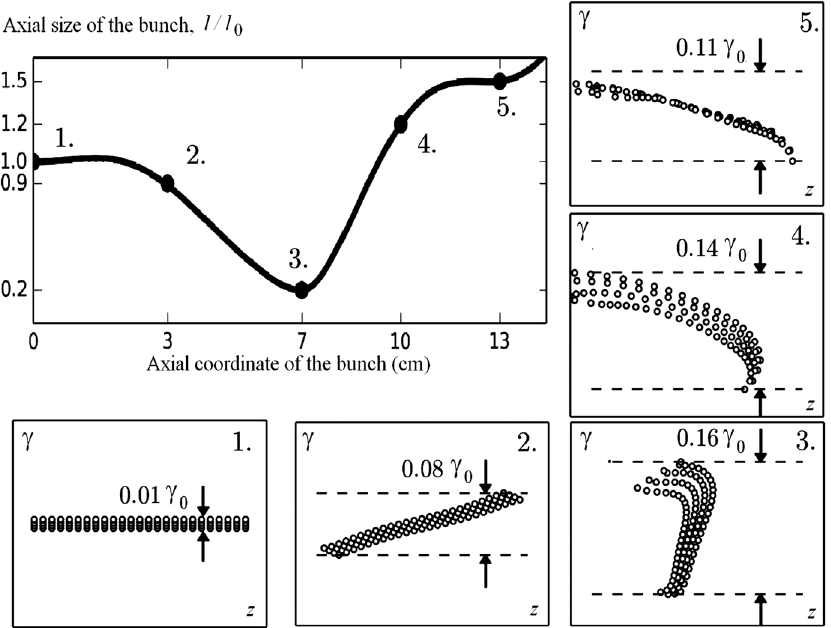
FIG. 8. Dynamics of the electron bunch with an initial length of 0.1 mm moving through a negative-mass undulator ( Δ ¼ − 0 . 4 ). Effective bunch length normalized to the initial value, l=l 0 , versus the axial coordinate of the bunch, as well as distributions of electrons on the phase planes (energy/axial position) at different stages of the bunch motion.